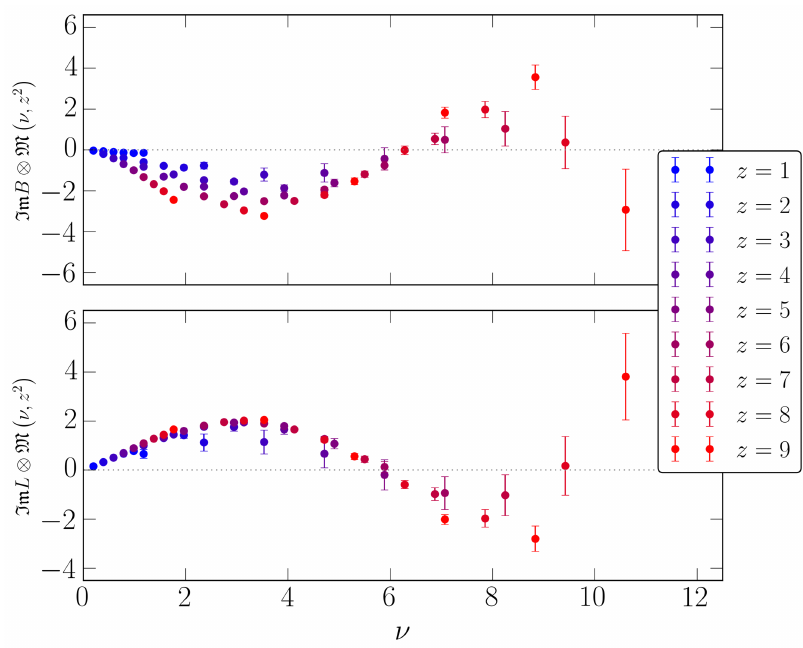
Figure 6. Convolutions needed to (upper) evolve and (lower) match the imaginary component of the reduced pseudo-ITD to a common scale of 2 GeV in MS. The NLO prefactor α included in these data, but omitted from the labels for clarity. The convolutions were performed up to z/a = 16 , but data for z/a > 9 are generally noisy and not shown.